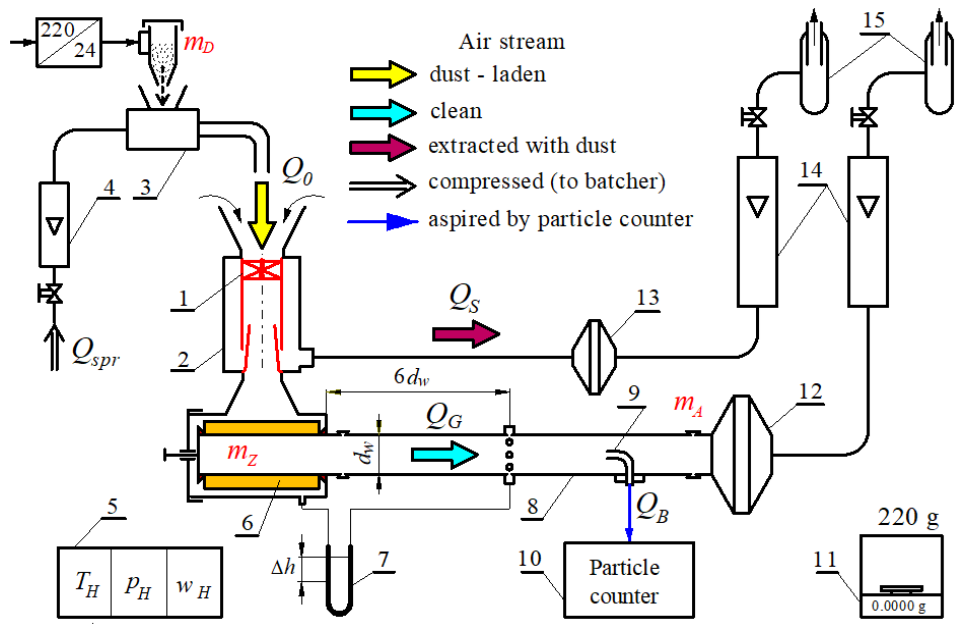
Figure 3. Filter cartridge test stand functional diagram: 1—cyclone; 2—dust collector; 3—dust dispenser; 4—rotameter; 5—instrument for determining air humidity, ambient temperature, and pressure; 6—tested filter cartridge; 7—U-type manometer tube; 8—measuring tube;